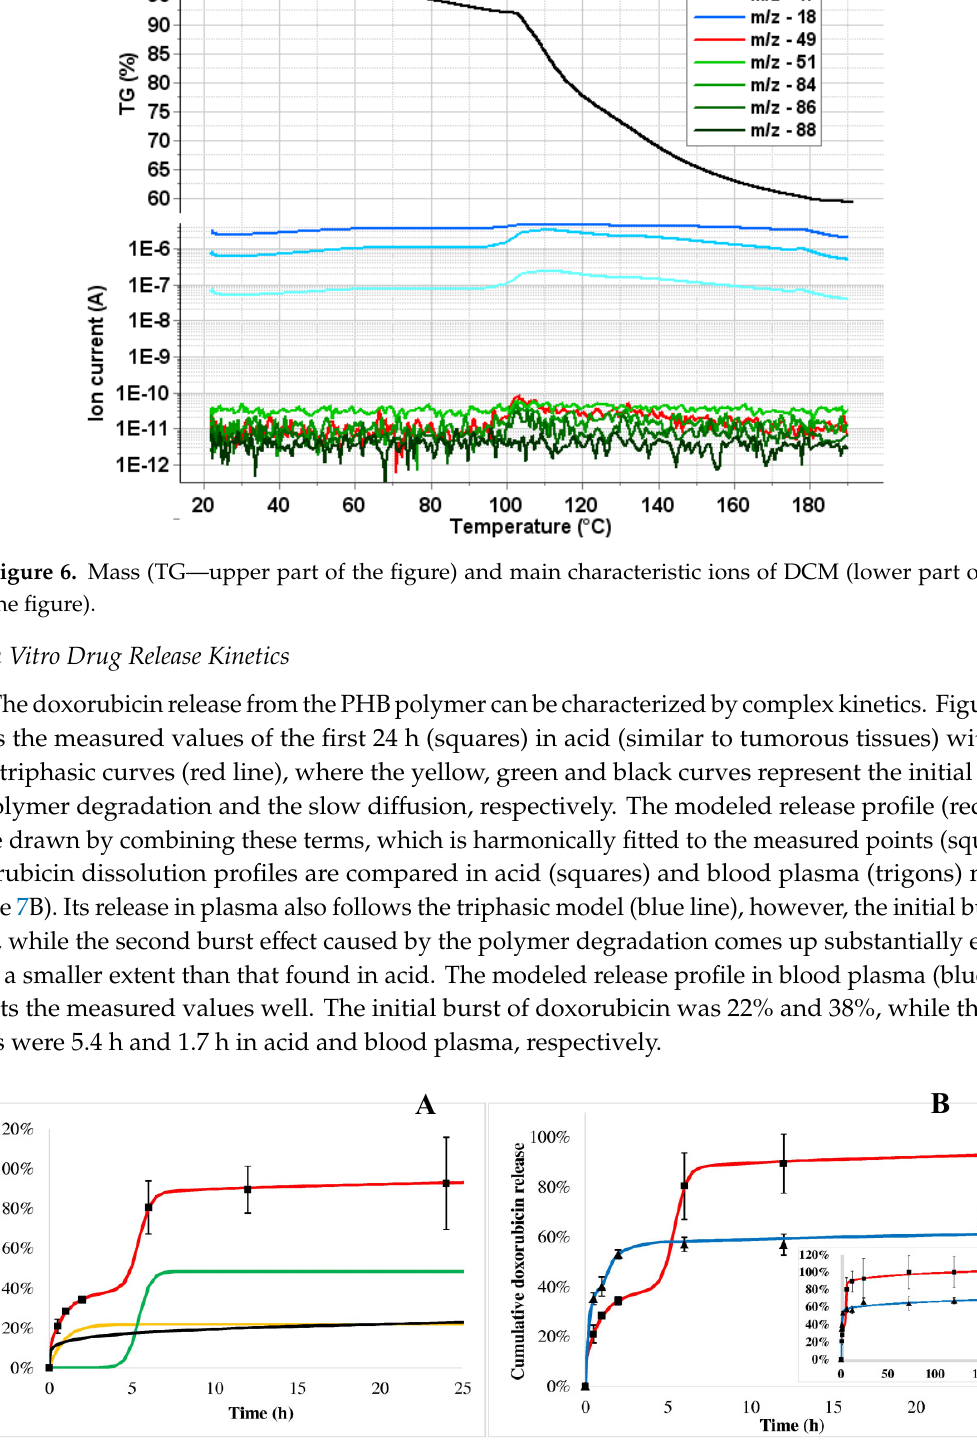
Figure 7. Doxorubicin cumulative release from PHB nanoparticles measured in acid (squares) and blood plasma (trigons). Colored lines show the modeled release profiles as follows: red line shows the release kinetics in the acid ( A ) built from the initial burst (yellow line), polymer degradation (green line) and diffusion (black line) in acid; blue line draws the release in blood plasma in ( B ). In the insert ( B ) the measured data and the fitted release profiles can be seen on the whole time scale.